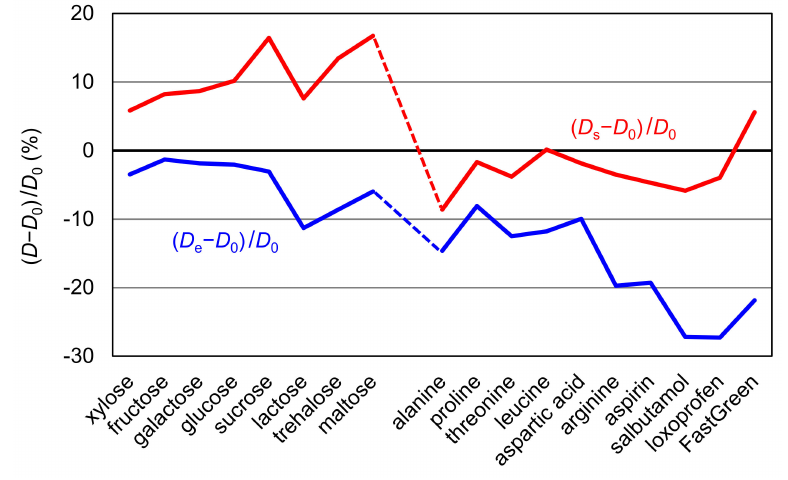
Figure 3. Relative deviations (%) of ( D s − D 0 ) / D 0 and ( D e − D 0 ) / D 0 were graphically represented for all